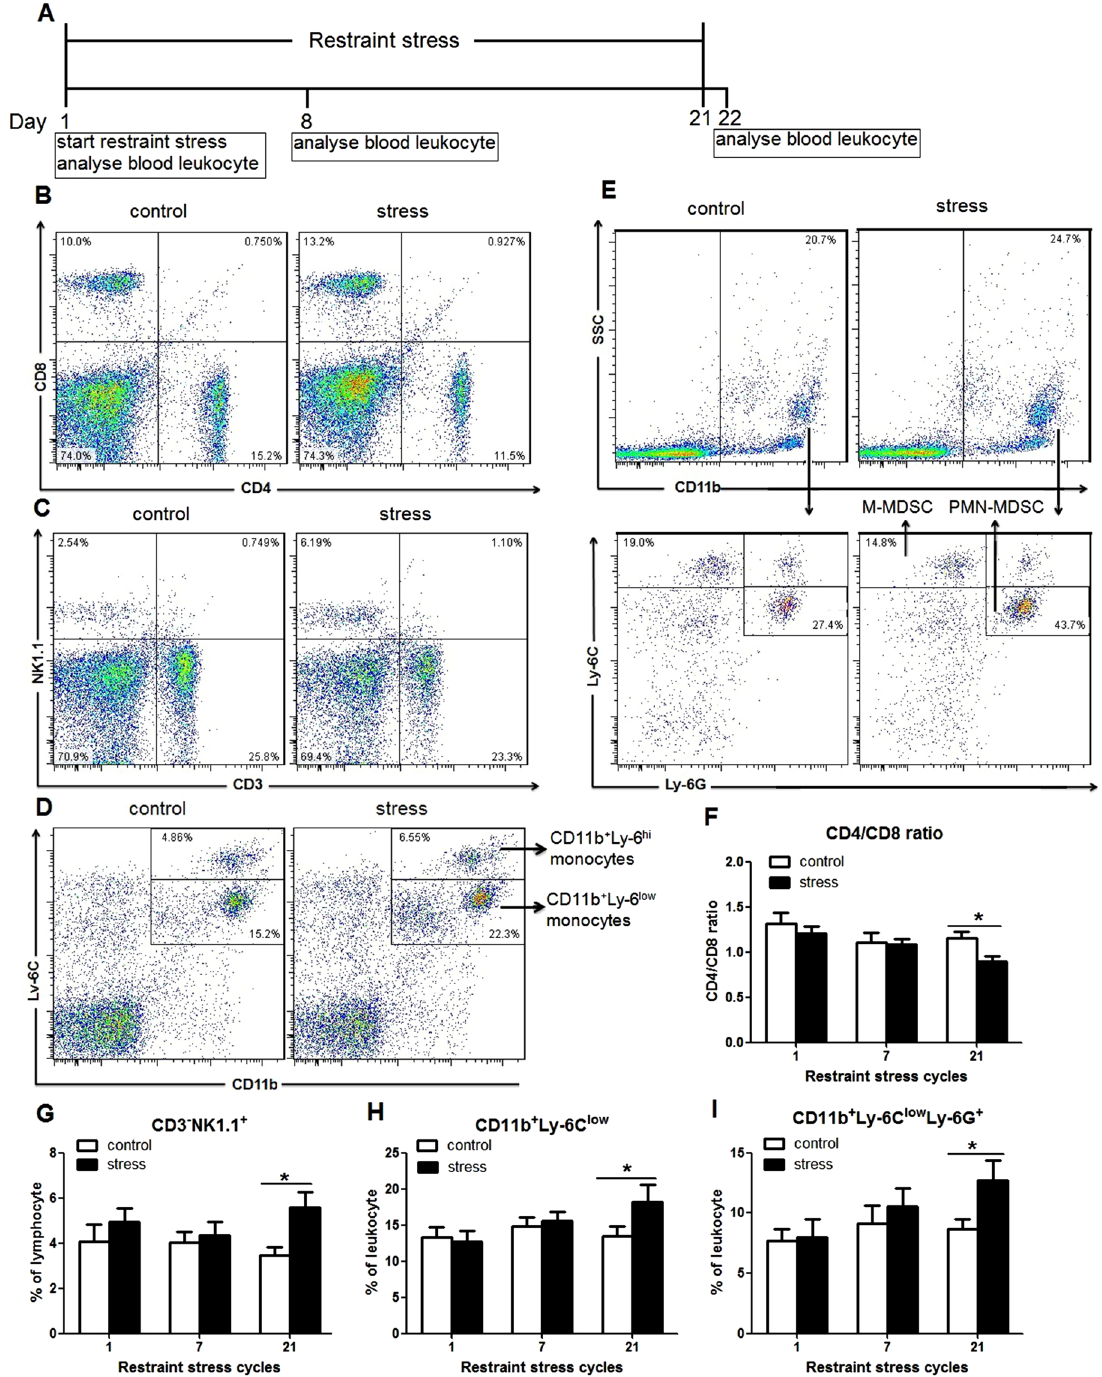
Figure 2. Leukocyte subsets of blood were changed after restraint stress. Blood was collected from the mice 1 h following the 1st cycle restraint stress, the day after undergoing 7 or 21 cycles of restraint stress. ( A ) Experiment designs to examine the changes of Leukocyte subsets of blood after restraint stress. ( B , C , D and E ) Representative dot plots of CD4 + , CD8 + T lymphocytes ( B ), CD3 − NK1.1 + NK cells ( C ), CD11b + Ly-6 low monocytes ( D ), and CD11b + Ly-6C low Ly-6G + PMN-MDSCs ( E ) in the mice undergoing 21 cycles of restraint stress and controls. ( F ) Twenty-one cycles of restraint stress decreased CD4/CD8 ratio. ( G , H and I ) Twenty-one cycles of restraint stress elevated the percentage of CD3 − NK1.1 + NK cells ( G ), CD11b + Ly-6 low monocytes ( H ) and CD11b + Ly-6C low Ly-6G + PMN-MDSCs ( I ). Data were shown as mean ± SEM (n = 8). * p < 0.05 vs.